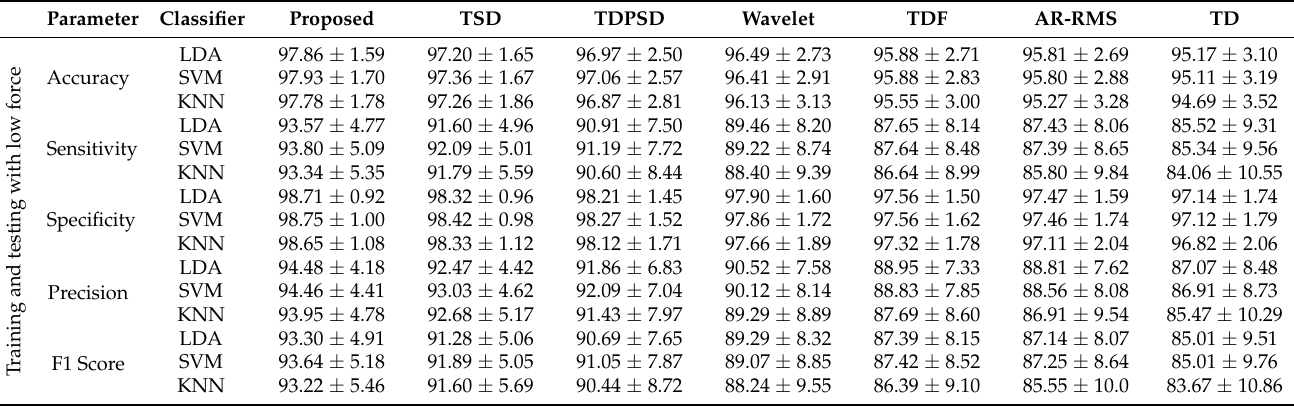
Table A1. The EMG pattern recognition performances when the classifiers are trained and tested with the same force level. Parameter